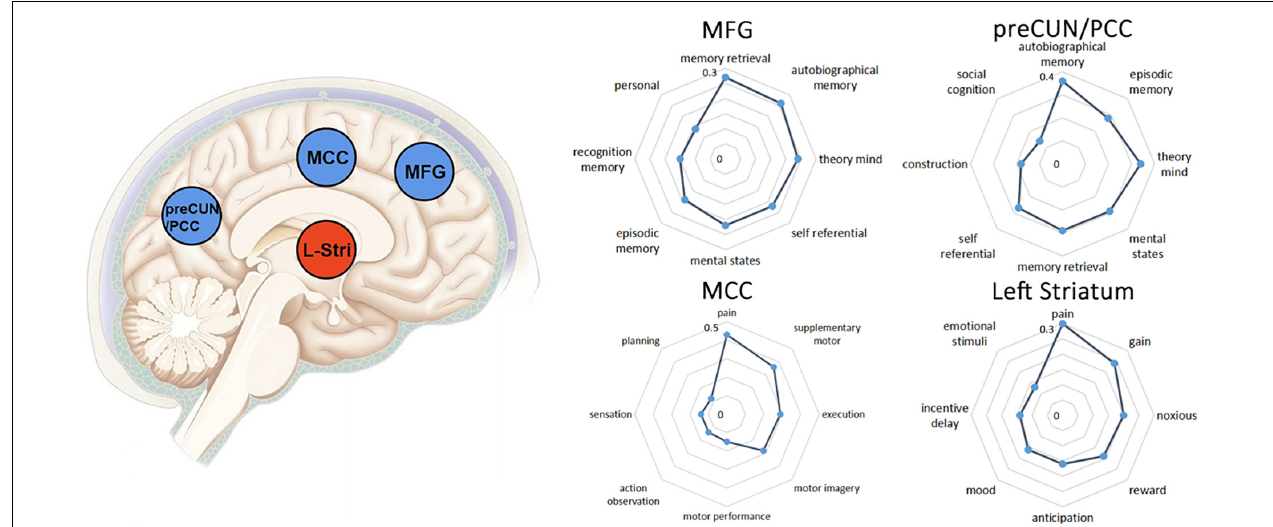
FIGURE 4 | The left column showed brain regions showing positive (blue) or negative (yellow) correlation with DoC in the meta-analysis. Clusters were displayed at voxel probability threshold P < 0.005, peak height Z ≥ 1 and cluster extent threshold > 10 voxels. The right column showed functional characterization of identified clusters. The statistics in the radar charts are r values from Pearson’s correlations. In the current Neurosynth framework, the r values reflect the correlation between two maps. preCUN, precuneus; PCC, posterior cingulate cortex; MCC, middle cingulate cortex; MFG, middle frontal gyrus.